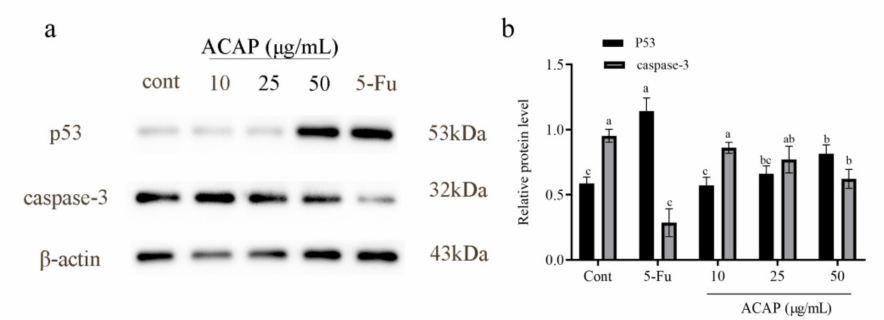
Figure 5. Effects of ACAP on p53 and caspase-3 expression levels in Hep G2 cells: ( a ) Western blotting analysis; ( b ) data from panel ( a ) expressed as bar graph. Notations as in Figure 3. Differing letters above bars indicate significant ( p < 0.05) differences according to Tukey’s multiple comparisons